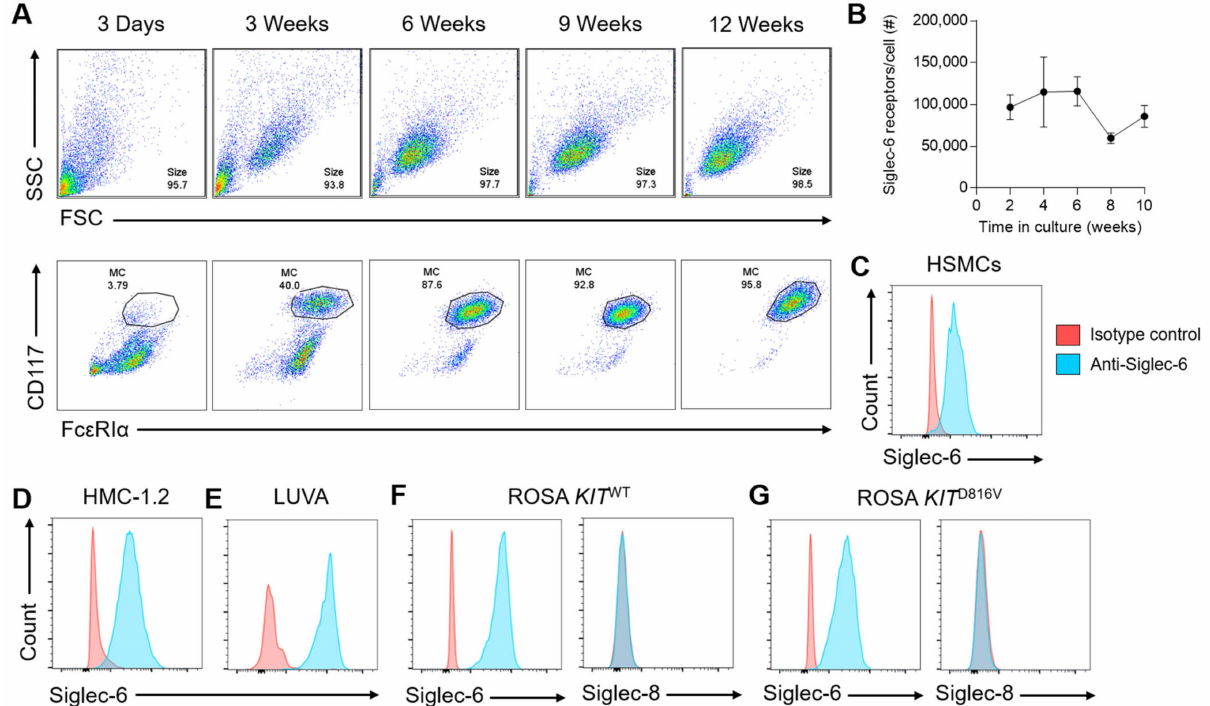
Figure 1. Siglec-6 surface expression on human primary mast cells (MCs) and MC lines. Primary human MCs were isolated and cultured from surgical skin specimens. ( A ) MC purity was determined by flow cytometry based on size, granularity, and expression of the MC markers CD117 and Fc ε RI α . ( B ) The number of Siglec-6 receptors per MC was determined by quantitative flow cytometry over time in culture. The expression of Siglec-6 on human skin-derived mast cells (HSMCs) ( C ) and the MC lines HMC-1.2 ( D ), LUVA ( E ), ROSA KIT WT ( F ), and ROSA KIT D816V ( G ) was assessed by flow cytometry relative to staining with an isotype control mAb. Siglec-8 staining, or lack thereof, is also shown for ROSA KIT WT ( F ), and ROSA KIT D816V ( G )